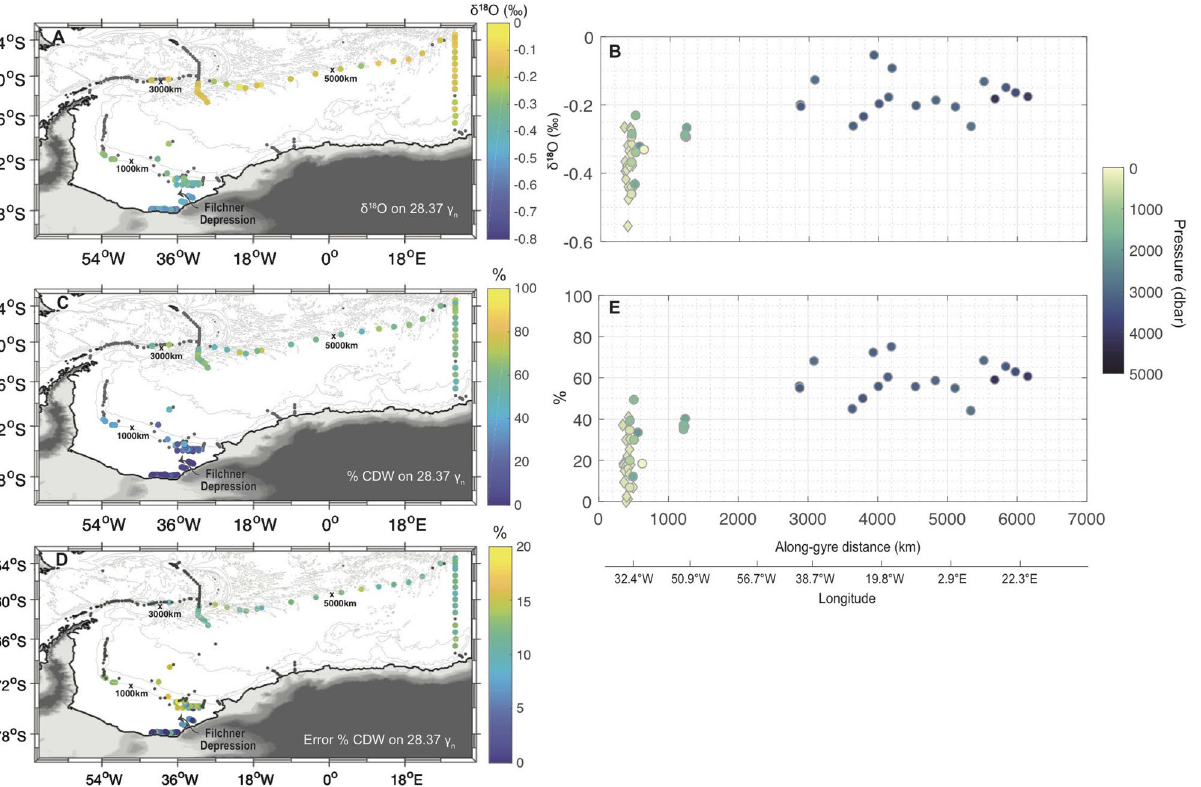
3 γ 18 Figure 3. ( A ) Spatial maps of δ O on the 28.37 kg m − n surface, and ( B ) corresponding stream-wise change 18 of δ O along the rim of the gyre from the Filchner Depression (origin of the along-gyre distance in abscissa) to the northeastern corner of the gyre (see Fig. 1C). ( C ) Spatial maps of fraction of CDW and its corresponding 3 γ error ( D ) on the 28.37 kg m − n surface, and ( E ) corresponding to stream-wise change of % of CDW along the rim of the gyre from the Filchner Depression to the northeastern corner of the gyre. Maps were produced using the software Matlab